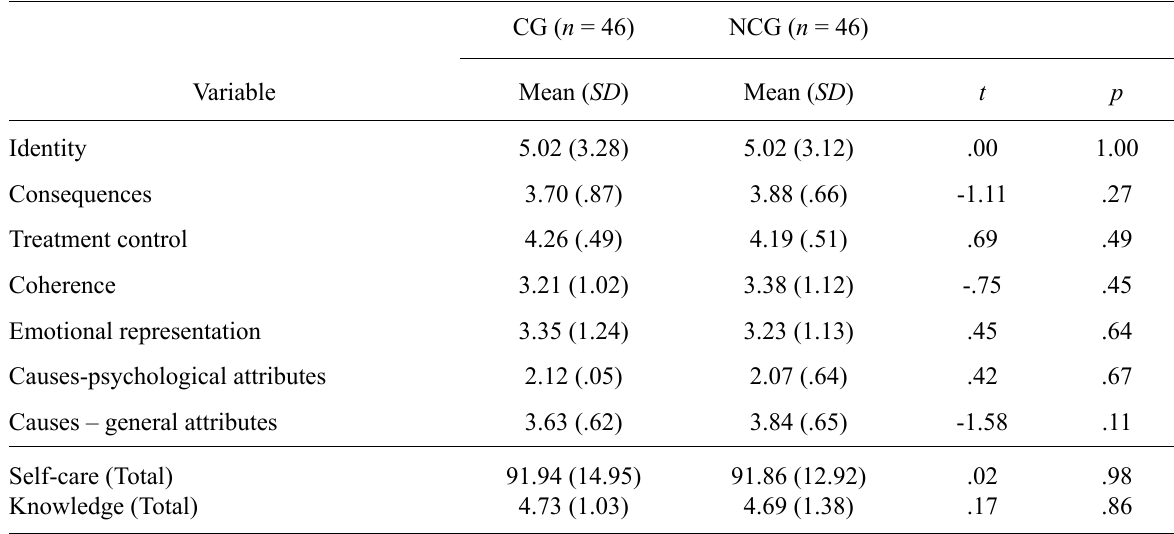
Comparison of Perception of Disease, Self-Care and Knowledge among Groups CG and NCG (Averages, Standard Deviation, t